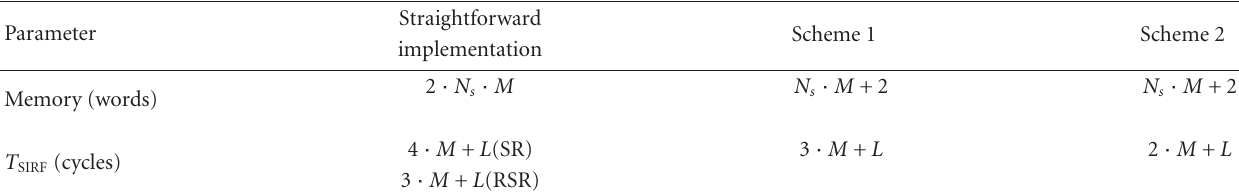
Table 4: Comparison of memory requirement and cycle time with a straightforward